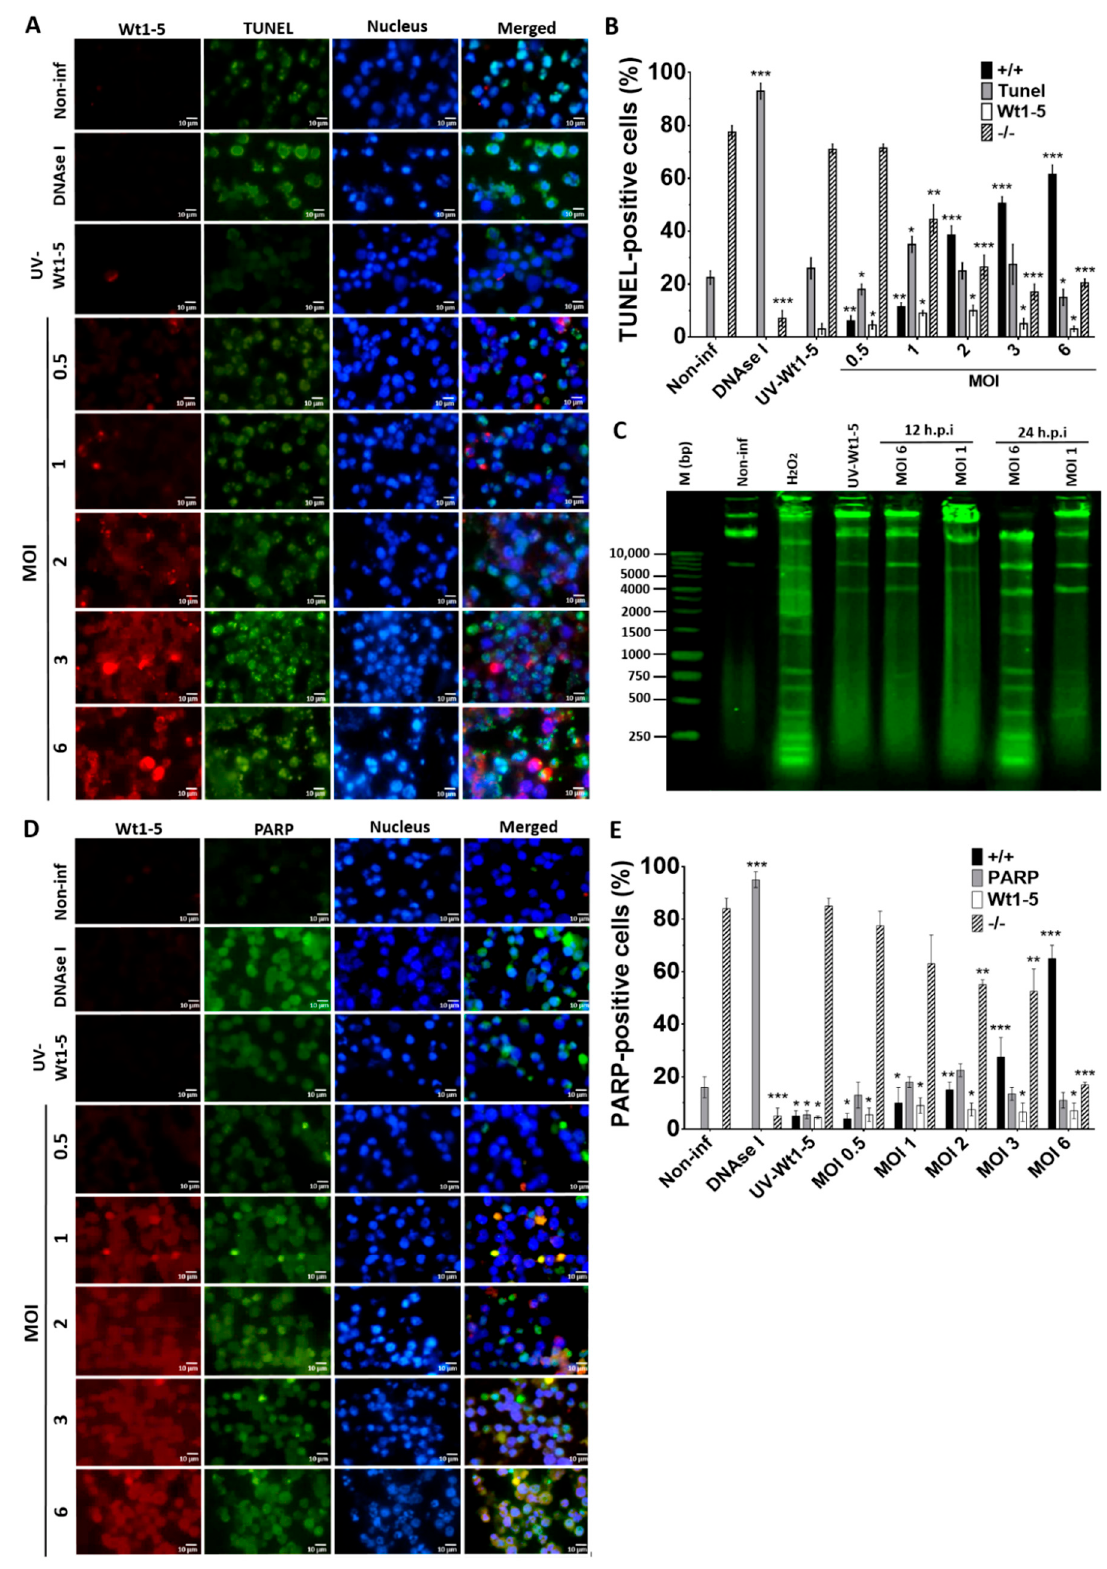
Figure 5. Nuclear fragmentation induced by Wt1-5 infection of Reh cells. Reh cells at a logarithmic growth phase were infected or not infected with trypsin-activated Wt1-5 (MOI 0.5 to 6) in RPMI culture medium without FBS. UV-inactivated Wt1-5-infected cells and DNAse I-treated cells after permeabilization were used as a control. ( A ) Representative photographs of immunofluorescence analysis for TUNEL assays are shown. Cells were labeled with Alexa Fluor 488 (green) for TUNEL,